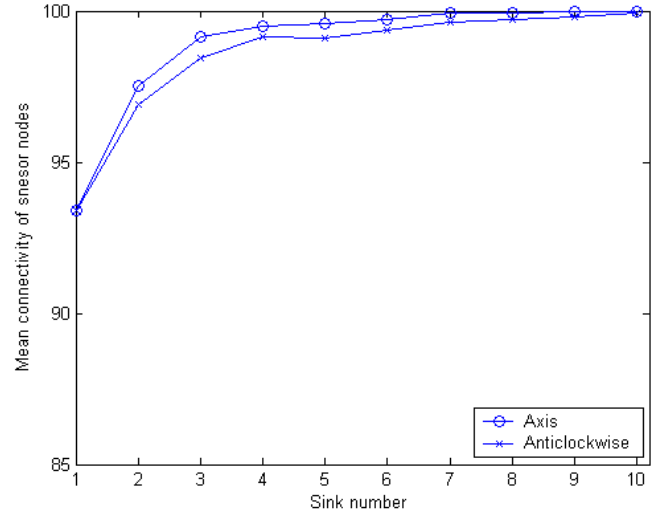
Figure 13. Mean connectivity of MSCWSNs-PC at variety sink number with considering MSBSRC (mean of 1,000